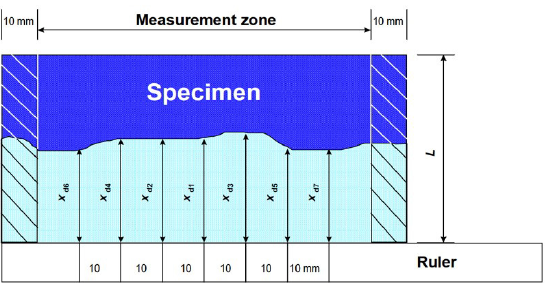
Figure 3. Illustration of the chloride penetration depth measurements